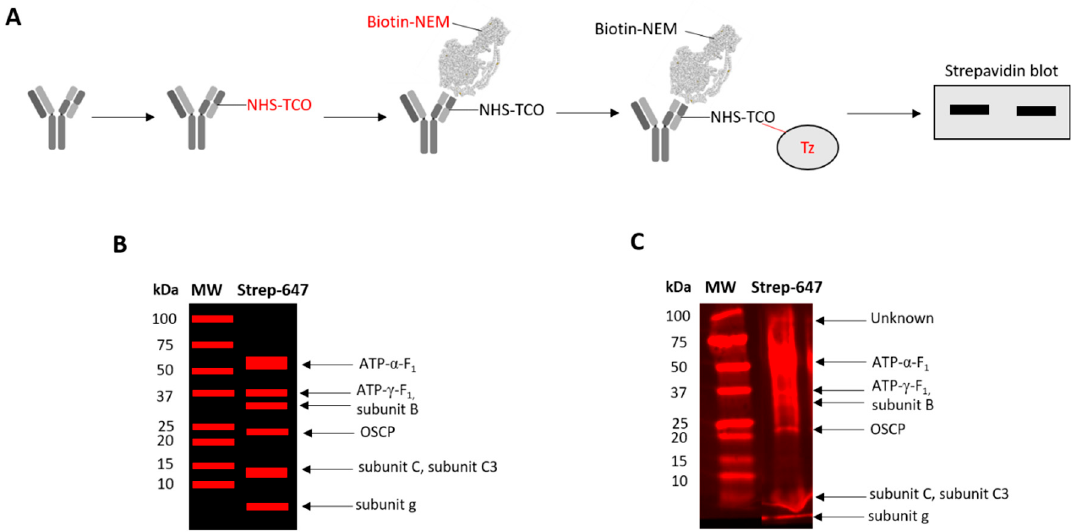
Figure 3. Several F 1 -F o ATP synthase subunits are reversibly oxidised. ( A ). Catalyst-free trans-cyclooctene-6methyltetrazine (TCO-Tz) immunocapture coupled to redox affinity blotting workflow. From left to right: Primary amines in the ATP- α -F 1 antibody are labelled with a heterobifunctional NHS-PEG4-TCO linker. After excess NHS is quenched with Tris (not shown), the labelled antibody is incubated with Biotin functionalised maleimide labelled reversibly oxidised thiols in mitochondrial membranes to capture the F 1 -F o ATP synthase. Agarose beads substituted with 6-methyltetrazine are then used to selectively capture the antibody-synthase complex. After washing away contaminants with a spin cup, samples are boiled, denatured, and reduced to elute subunits for streptavidin blotting. Streptavidin, conjugated Alexa Fluor™ 647 positive bands denote reversibly oxidised subunits. ( B ). A predicted reversibly oxidised subunit profile based on Table 1. ( C ). Representative image of an experimentally observed reversibly oxidised subunit profile alongside a molecular weight (MW) ladder. Arrows indicate the predicted identity of the observed bands. The image shows several F 1 -F o ATP synthase subunits are reversibly oxidised. An unpredicted band at 100 kDa was observed (see main text). Clickable TCO-Tz immunocapture coupled to redox affinity blotting was performed on five pools of 10 X. laevis oocytes. Each lane represents the weighted mean of 10 oocytes.